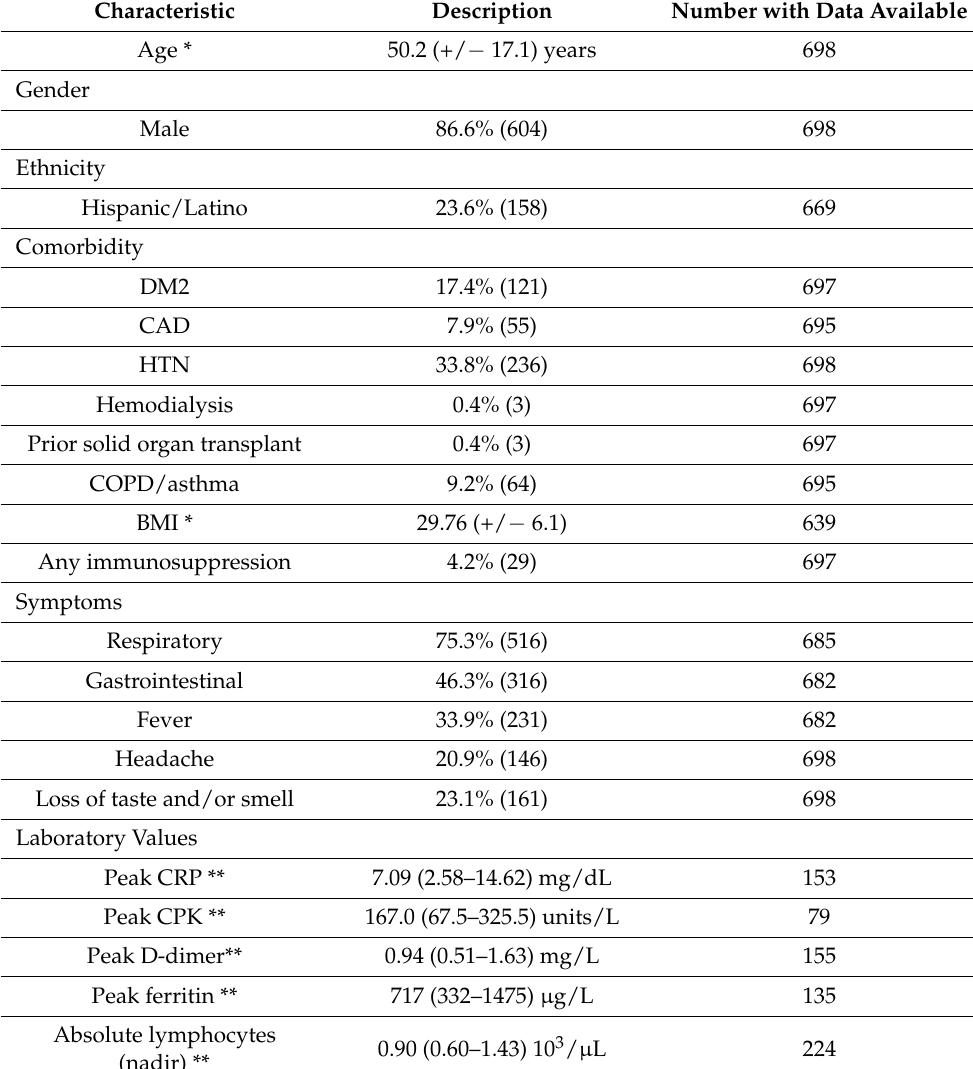
Table 4. Descriptive characteristics of the